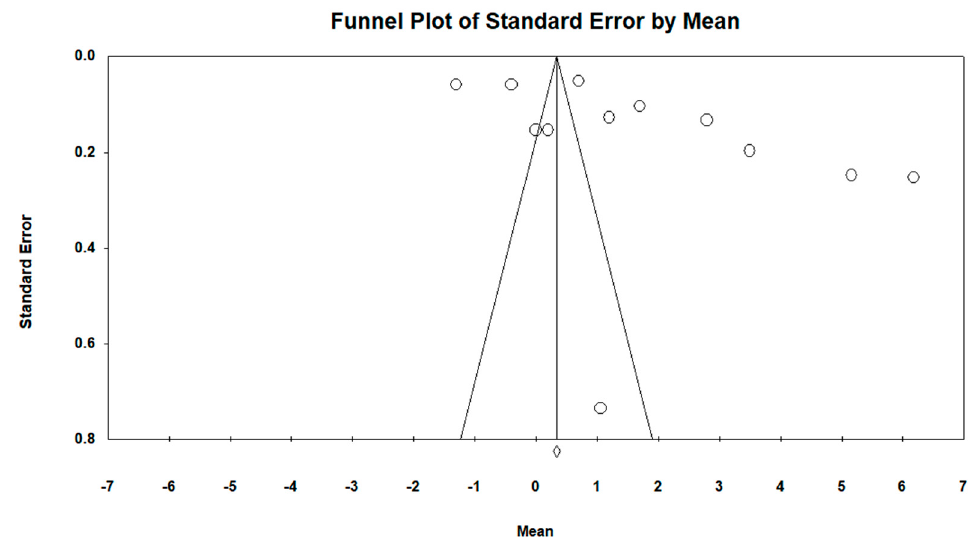
Figure 7. Funnel plot diagram of the standard error ( y -axis) and the SMD ( x -axis): difference between groups in the intervention group with resistance therapy on the GMFM scale in all follow-ups.